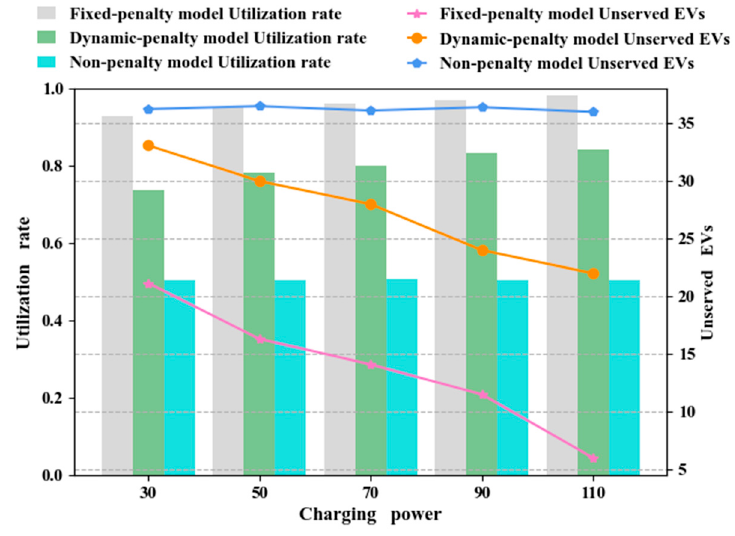
Figure 13. The impact of improving charging facilities’ output power on unserved EVs and utilization.